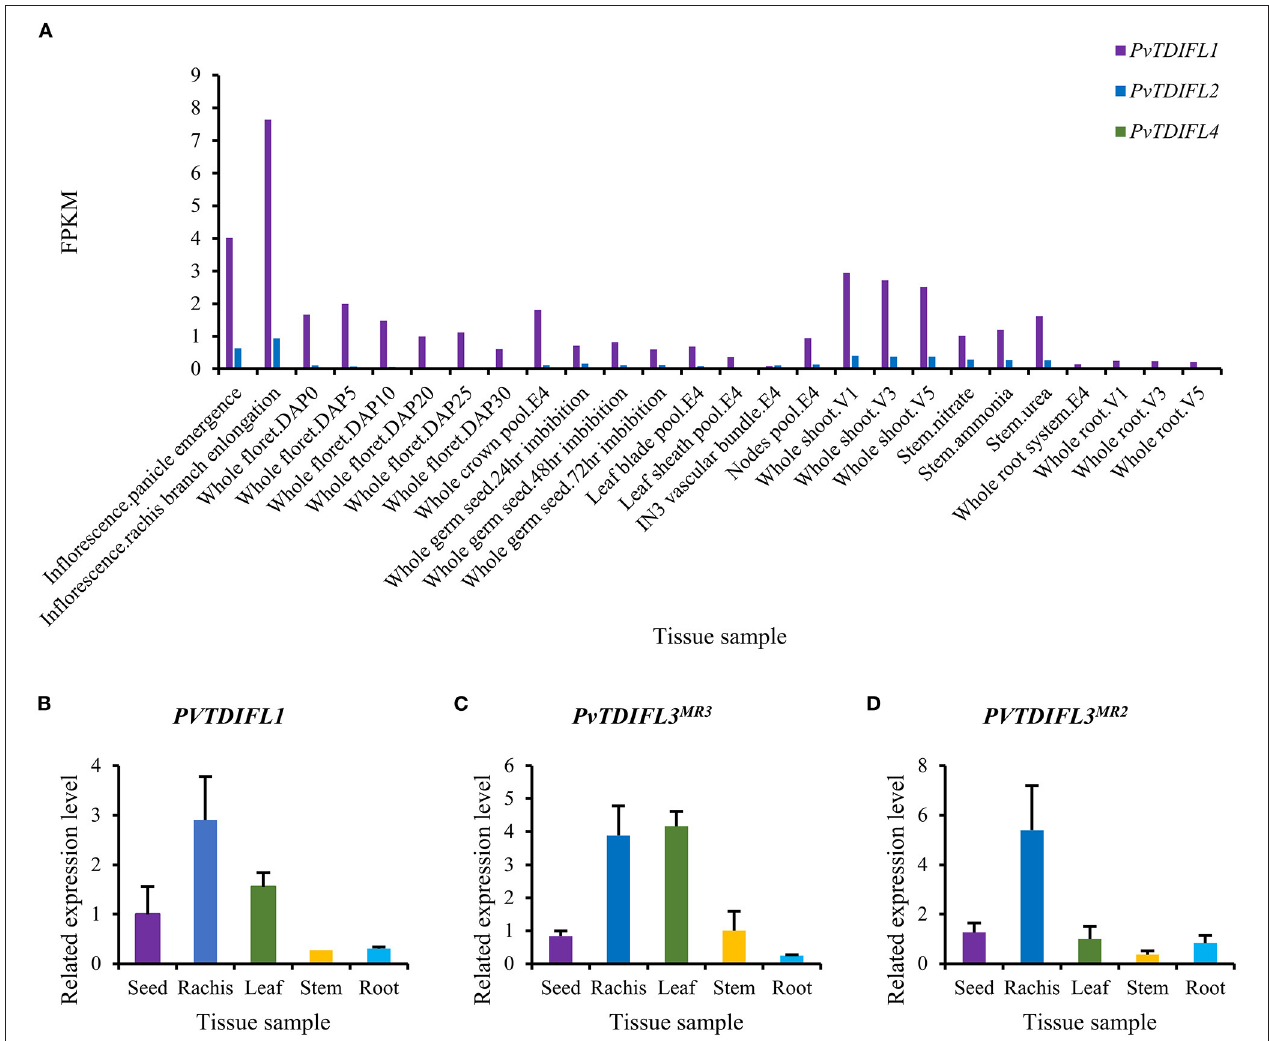
FIGURE 3 | Expression analysis of PvTDIFL genes in P. virgatum . (A) Expression of PvTDIFL1 , 2 and 4 in different samples of P. virgatum . Fragments Per Kilobase per Million (FPKM) values of PvTDIFL1 , 2 , and 4 were obtained from in silico expression data in Phytozome. Samples listed are as follows: Inflorescence.Panicle emergence, Inflorescence.rachis branch elongation, Whole floret.DAP0, 5, 10, 20, 25, 30, Whole crown pool.E4, Whole germ seed 24h imbibition, 48h imbibition, 72h imbibition, Leaf blade pool.E4, Leaf sheath pool.E4, IN3 vascular bundle.E4, Nodes pool.E4, Whole shoot.V1, 3, 5, Stem.nitrate, Stem.ammonia, Stem.urea, Whole root system.E4, Whole root.V1, 3, 5. (B–D) Relative expression levels of PvTDIFL1 (B) , PvTDIFL3 MR 3 (C) , and PvTDIFL3 MR 2 (D) quantified using qRT-PCR. Seed (mature), rachis (bearing mature seeds), leaf (fully expanded leaf), stem (middle internode), and root of switchgrass grown on campus were collected in